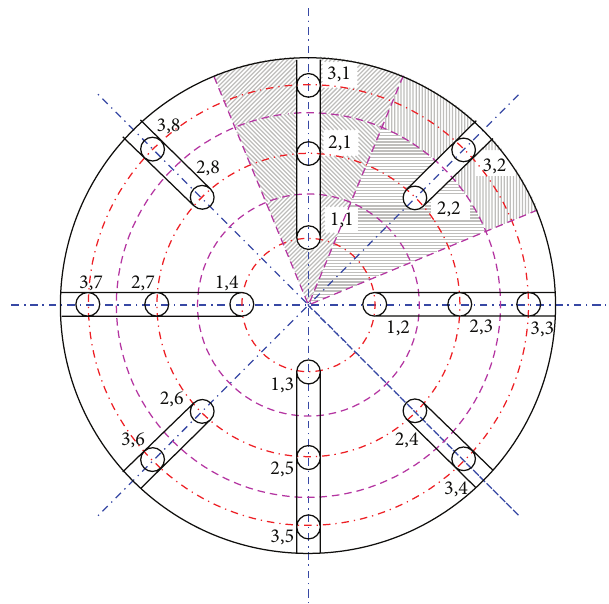
Figure 11: Schematic arrangement of the twenty jets in three circumferential